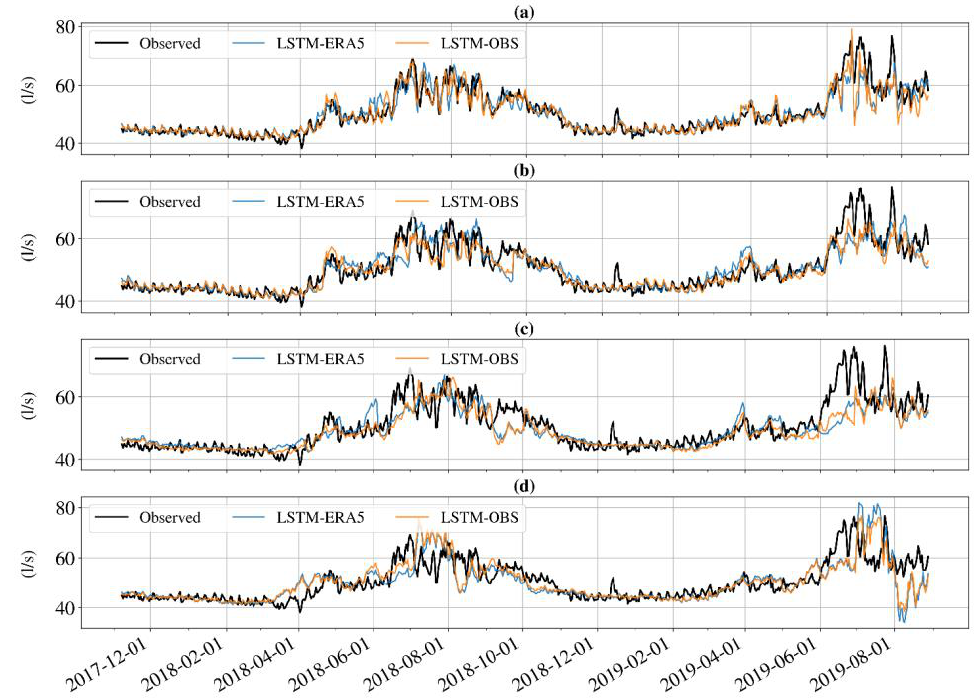
Figure 4. Observed water demand (black) and modelled water demand for LSTM-OBS (orange) and LSTM-ERA5 data (blue) for testing period for case study 2. ( a ) 7 days horizon ( b ) 14 days horizon ( c ) 30 days horizon ( d ) 60 days